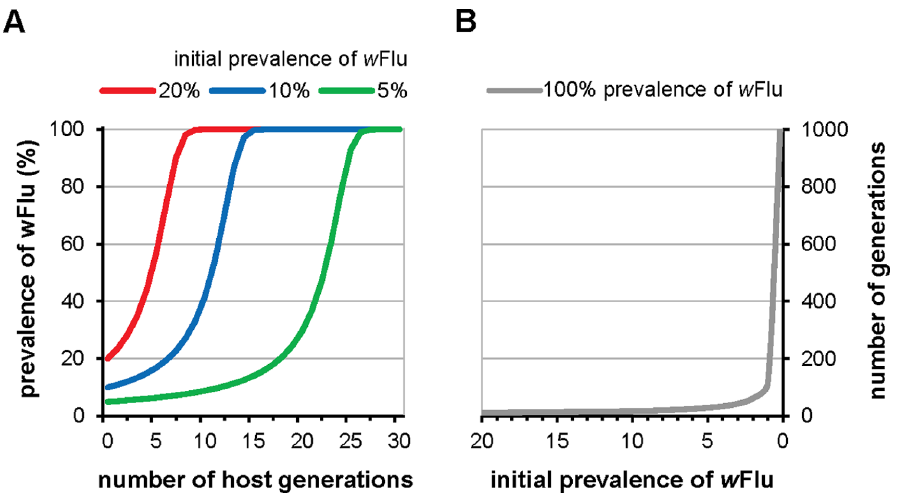
Figure 4. Mathematical modelling of the ability of w Flu to invade host populations. Theoretical prediction of the ability of the Wolbachia strain w Flu to invade uninfected host populations using the empirically-determined laboratory-based parameter estimates observed in this study for w Flu in its native host Ae. fluviatilis , and equation (1) from Dobson et al [62], modified from Turelli & Hoffmann [130]. Graph A shows three different predictions of the rate of spread of w Flu based upon three different initial prevalences of w Flu in the host population (5, 10 and 20%), which can be interpreted as the size of released Wolbachia -infected seed populations relative to the uninfected host population during a vector control programme. Graph B shows the general relationship between the initial prevalence of w Flu and the number of host generations required for w Flu to attain 100% prevalence in the host population. Coloured circles indicate values for the initial prevalences used in Graph A. The following parameter values were used to calculate the prevalence of infection ( p ) at generation time ( t ) by iteration: m , the maternal transmission efficiency (the proportion of uninfected offspring produced by infected mothers)=0.0 (i.e., complete maternal transmission was assumed; see main text for justification); H , the relative egg hatching rate (the ratio of hatched eggs from infected versus uninfected mothers)=0.071; a , the relative fitness of infected versus uninfected females=1.0 (i.e., no difference in fitness was inferred based on the survival and fecundity data presented in Figures 2 and 3, respectively). H was calculated using pooled total egg counts for the compatible and incompatible crosses shown in Figure 1, rather than the average hatch rate per female, in order to provide a more conservative estimate of the strength of cytoplasmic incompatibility (i.e., to account for the variation in the expression of cytoplasmic incompatibility observed with w Flu – see main text for detailed explanation).